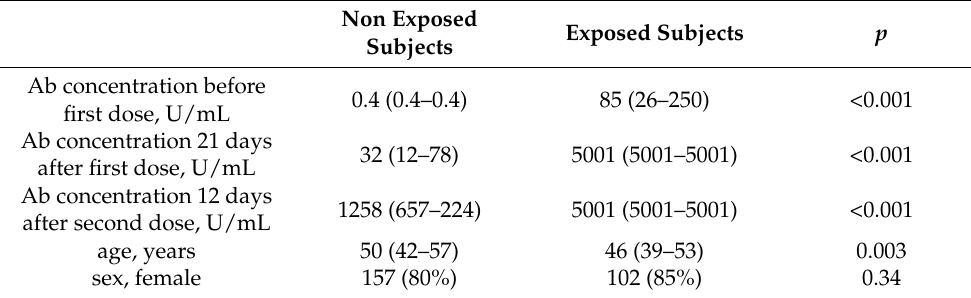
Table 1. Antibody concentration before and after first and second dose of BNT162b2.